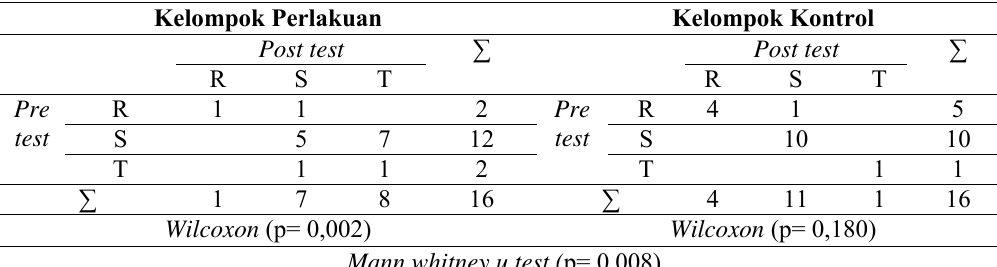
Tabel 2. Tabulasi silang pre test dan post test tingkat comfort